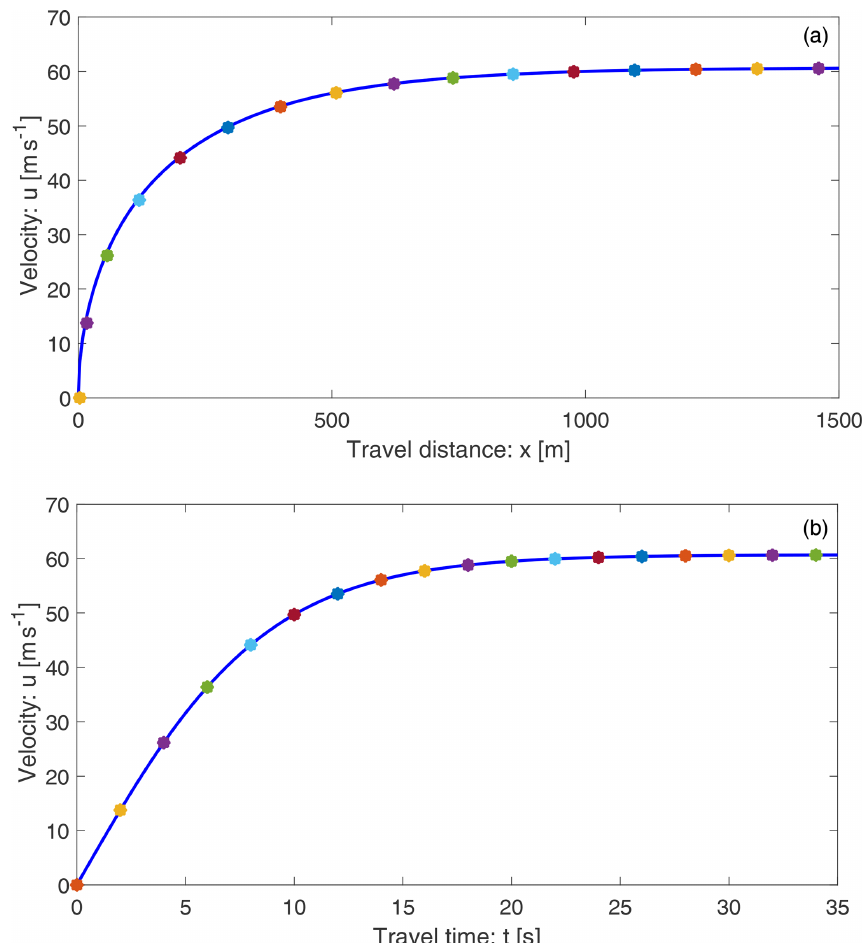
Figure 12. Spatial (a) and temporal (b) transportations of the initial velocity ( u = 0) of the landslide down the slope by the general solution system (Eqs. 39 and 40) as indicated by the star markings for times t = 0 . 0s, with 2.0s increments. These solutions exactly fit the space and time evolutions of the velocity fields (curves) for the mass point motions given by Eqs. (8) and